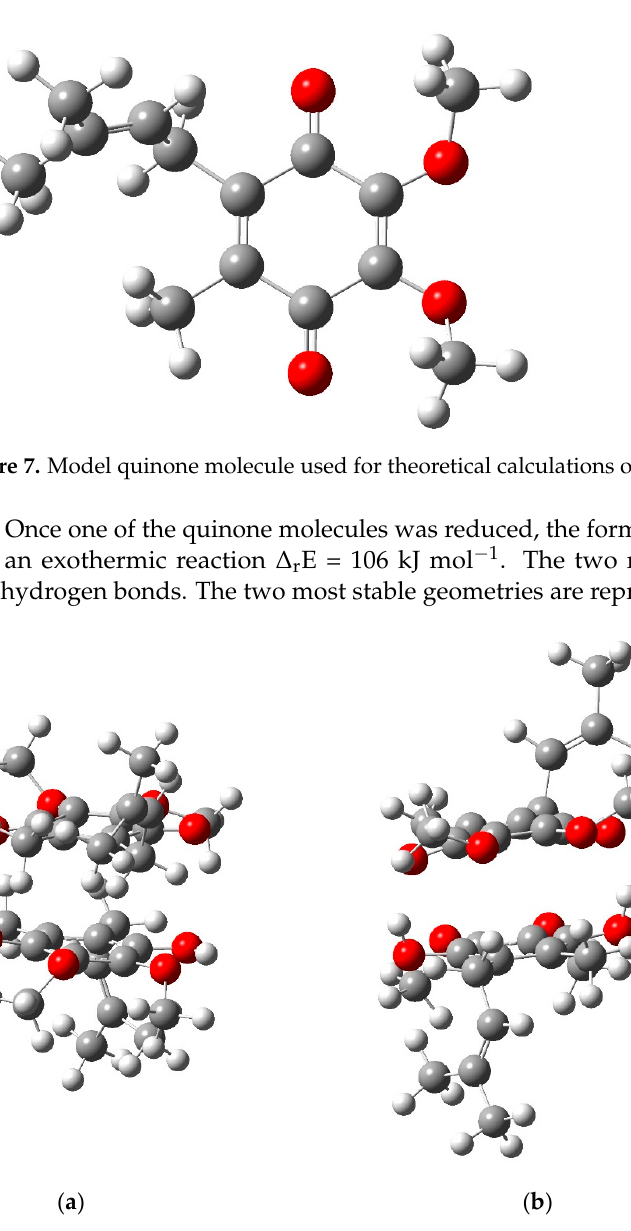
Figure 8. Stable quinone–quinol quinhydrone complex after optimizations. ( a ) Most stable geometry ( ∆ r E = 106 kJ mol − 1 ); ( b ) stable complex with two hydrogen bonds ( ∆ r E = 90 kJ mol − 1 ).